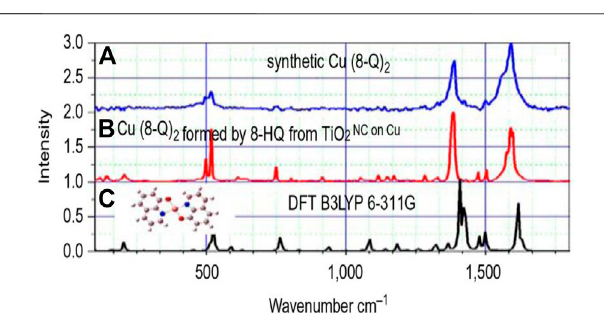
FIGURE 10 | Raman spectra of the synthetic Cu(8-HQ) 2 (B) , Cu(8-HQ) 2 formed as a result of the reaction between the released 8-HQ and copper substrate (A) , and theoretical Raman spectrum of the Cu(8-HQ) 2 compound (C) (Kordas et al.,